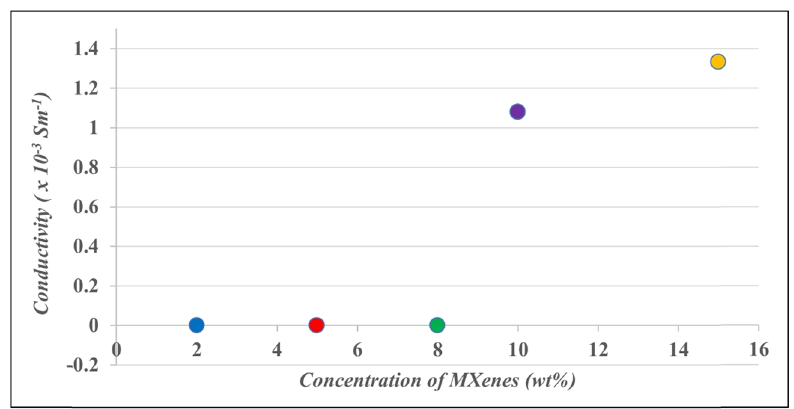
Figure 13: The electrical conductivity ( σ ) of nanocomposites is shown against the concentration of MXenes at room